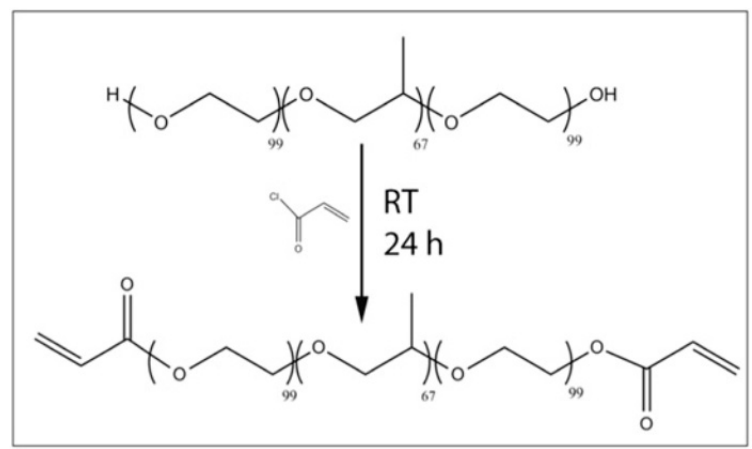
Figure 10. Chemical structure of Pluronic F127 before and after reaction with acryloyl chloride [149] .